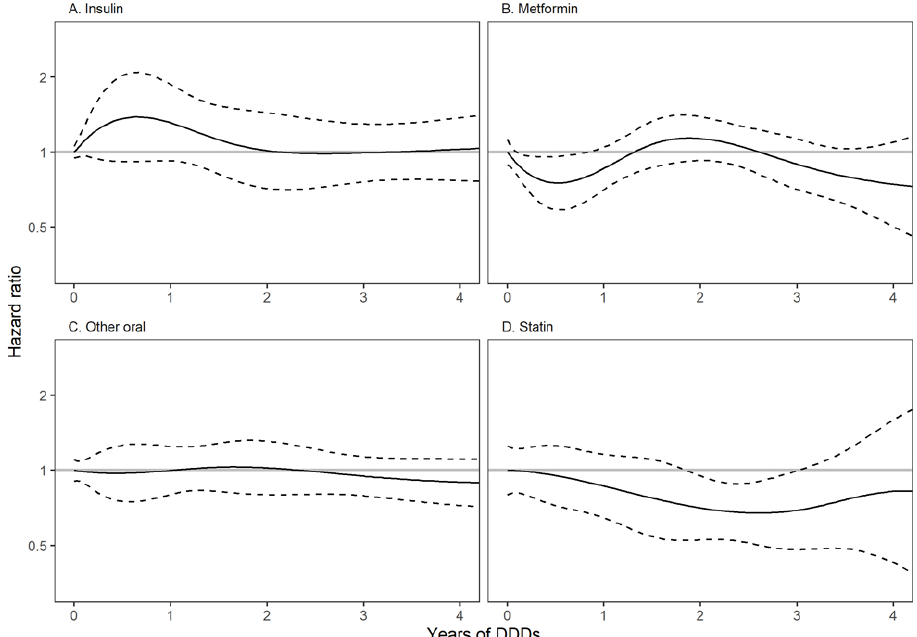
Figure 3. Estimated hazard ratios (with pointwise 95% confidence limits) of rectal cancer (RC) mortality by cumulative defined daily dose amount of antidiabetic medications and statins during the three years preceding RC diagnosis in selected medication groups. ( A ) = insulin, ( B ) = metformin, ( C ) = other oral ADM and ( D ) = statin. Solid line represents hazard ratio, with dashed lines indicat- ing 95% confidence intervals.